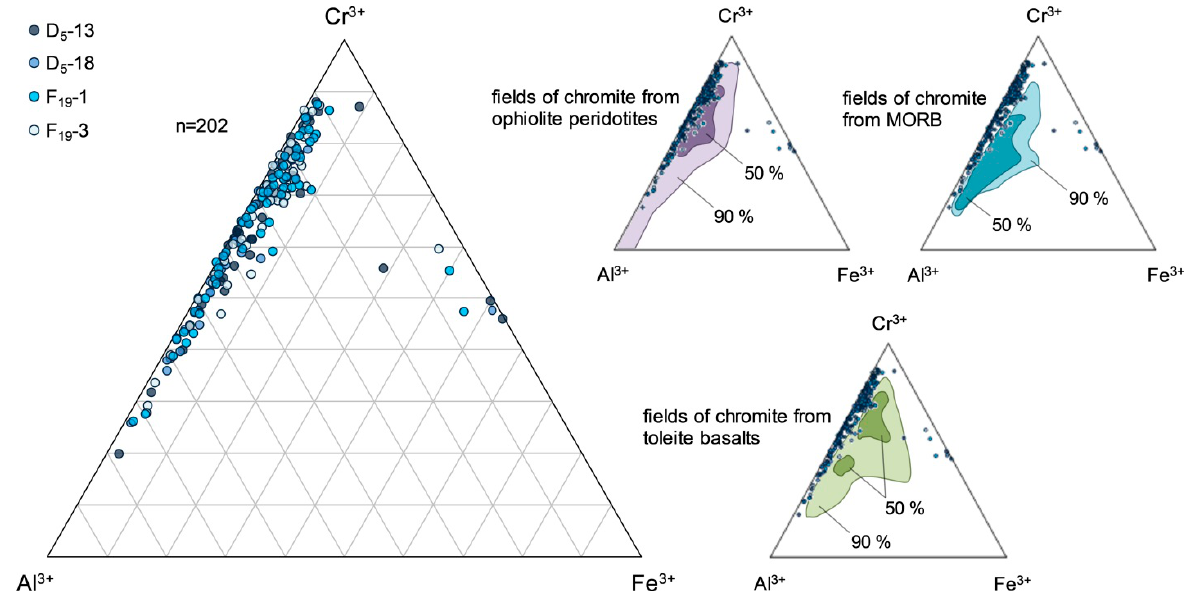
Figure 9. Ternary Cr 3+ –Al 3+ –Fe 3+ diagrams for chromspinels from the Sabantuy paleoplacer in comparison with fields of chromspinel composition from different complexes taken from [42].